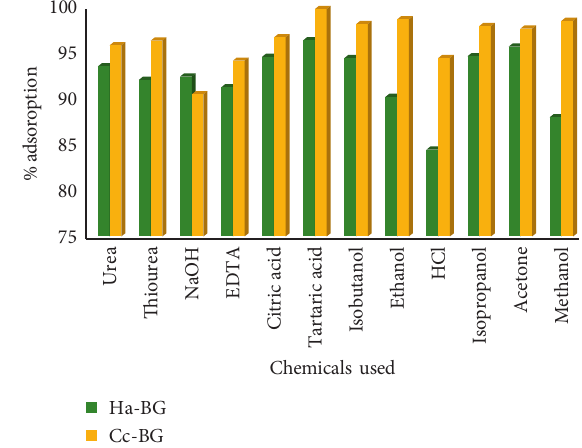
Figure 1: Chemical modification of